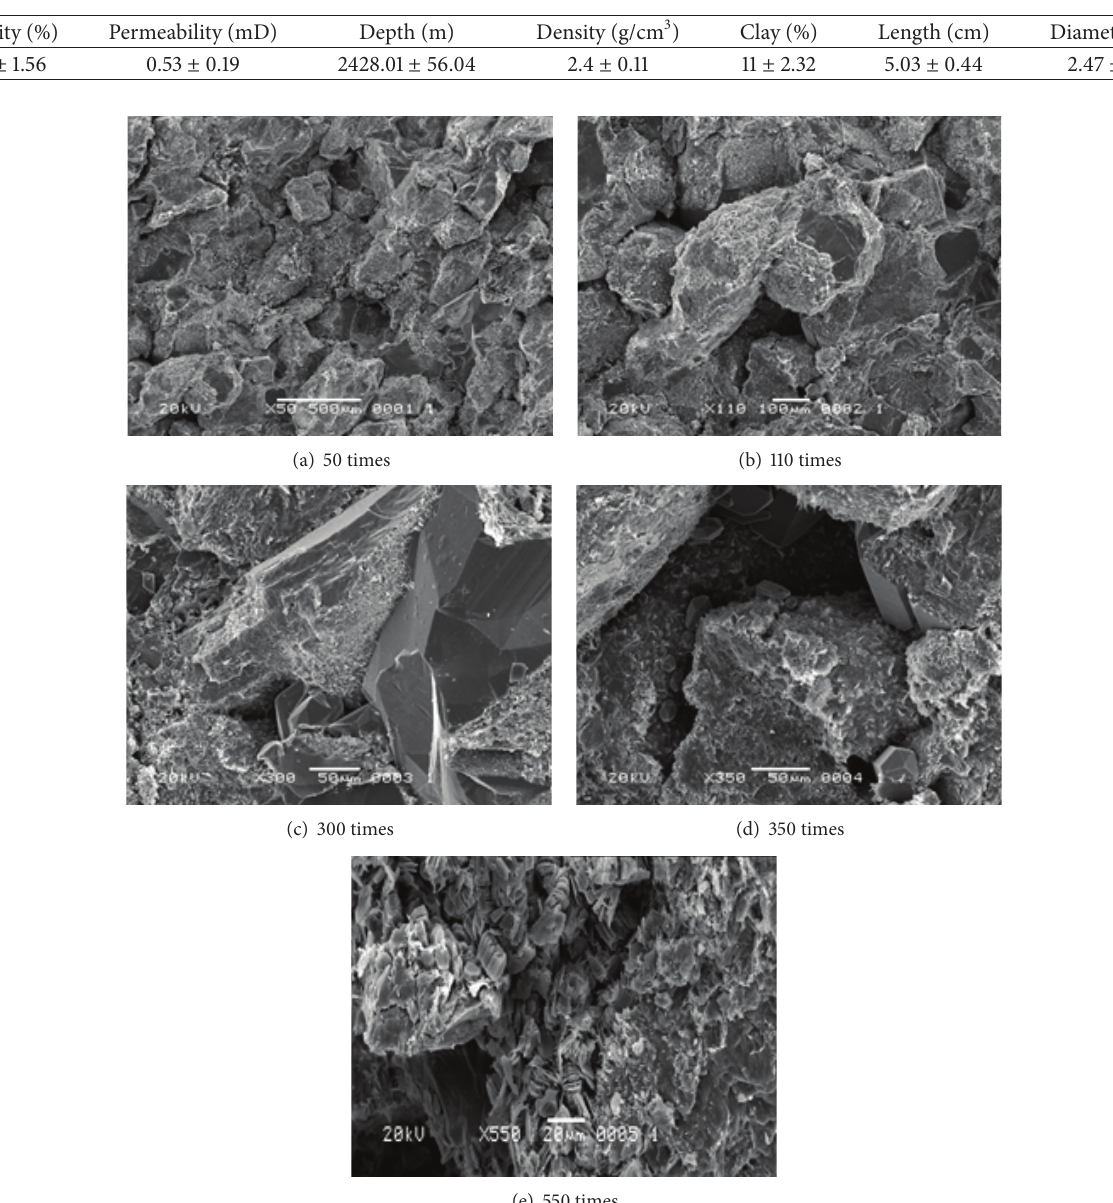
Table 1: Fundamental properties of this sandstone sample.